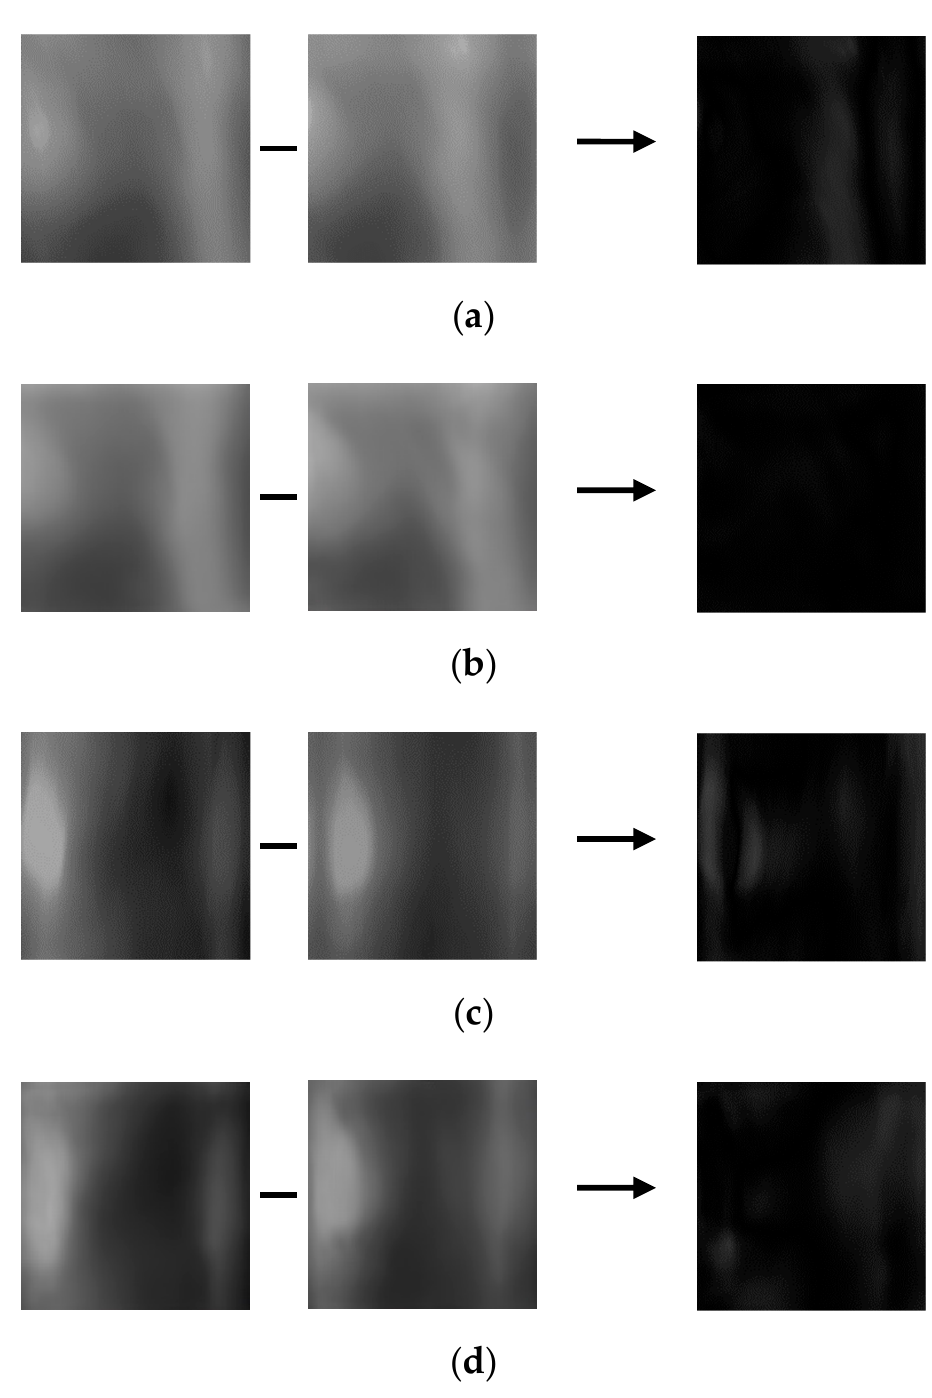
Figure 18. Correct recognition examples after restoring motion blur. ( a ) Incorrect genuine matching before restoring motion blur, ( b ) correct genuine matching after restoring motion blur, ( c ) incorrect imposter matching before restoring motion blur, and ( d ) correct imposter matching after restoring motion blur. From the left, examples in ( a – d ) present the registered, input, and difference images, respectively. Figure 19 is an example of incorrect authentic matching and incorrect imposter match- ing despite the restoration method proposed in this study is applied. In the case of incorrect authentic matching, the difference in motion blur between the same classes is so severe that it is recognized as an imposter even after restoration, resulting in incorrect matching. In the case of incorrect imposter matching, the enrolled image and the input image